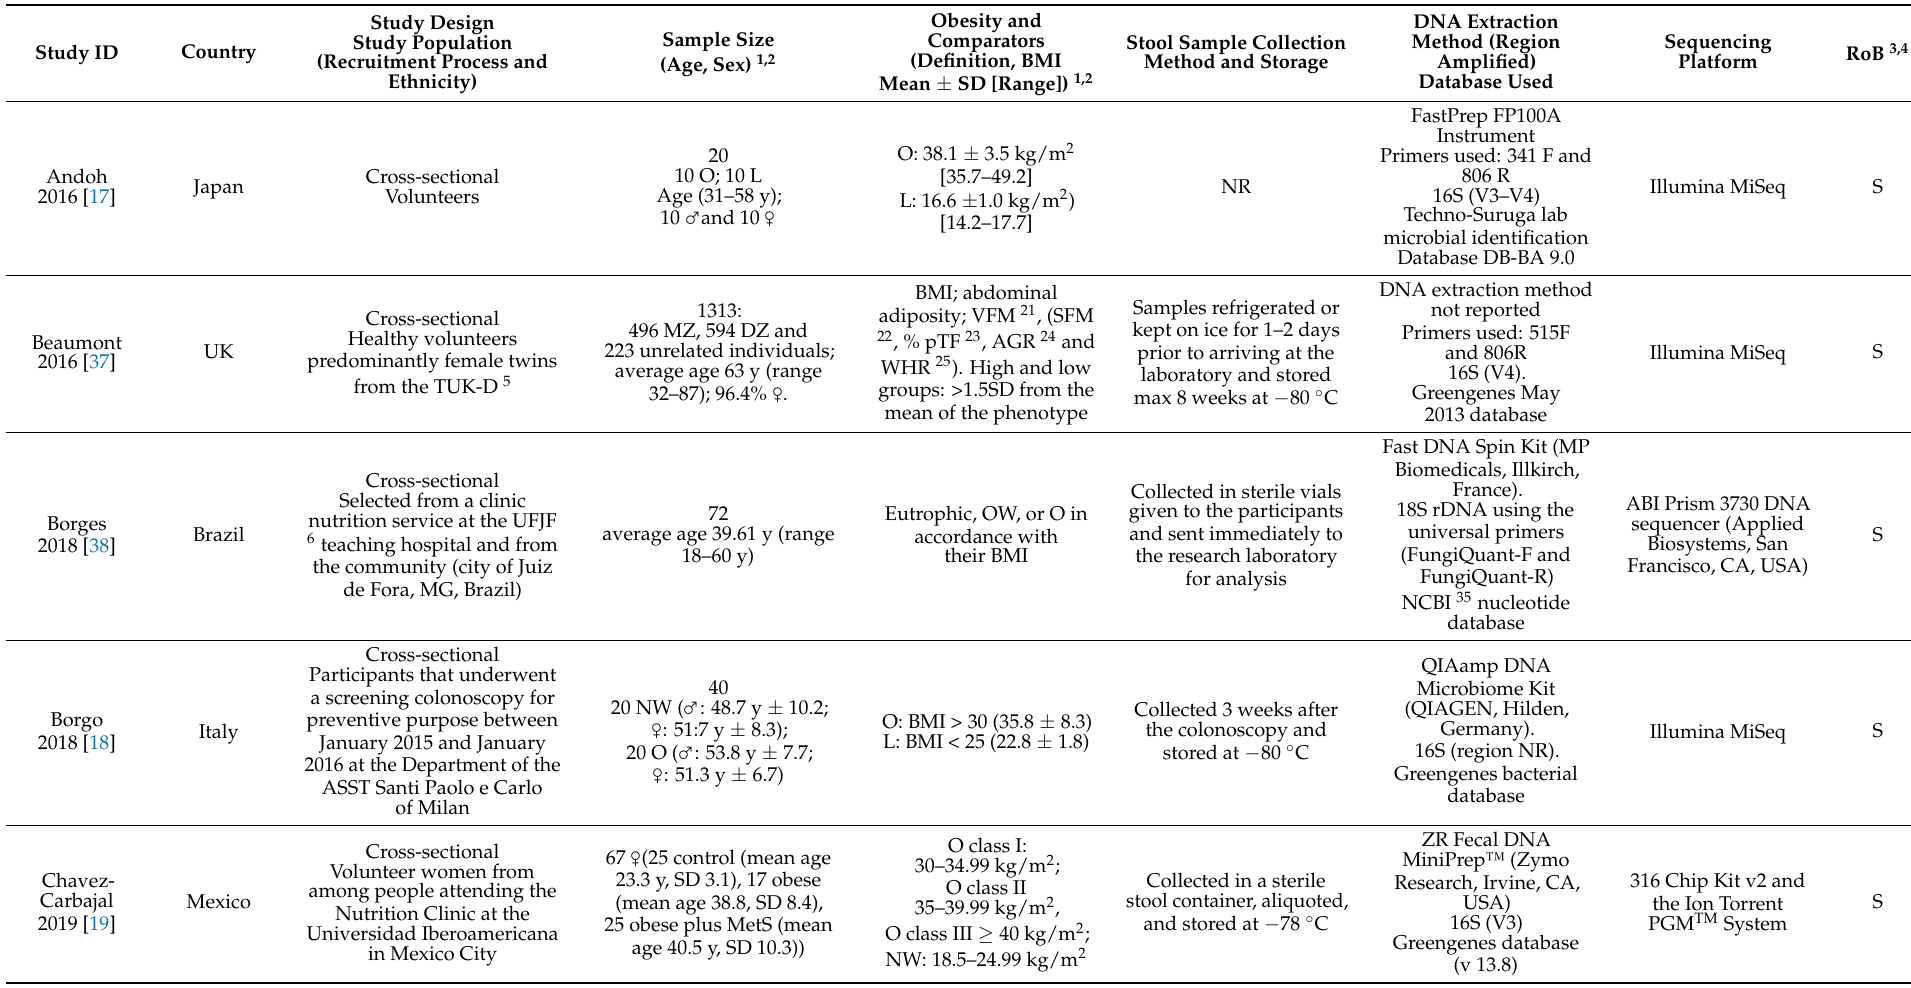
Table 1. Characteristics of the included